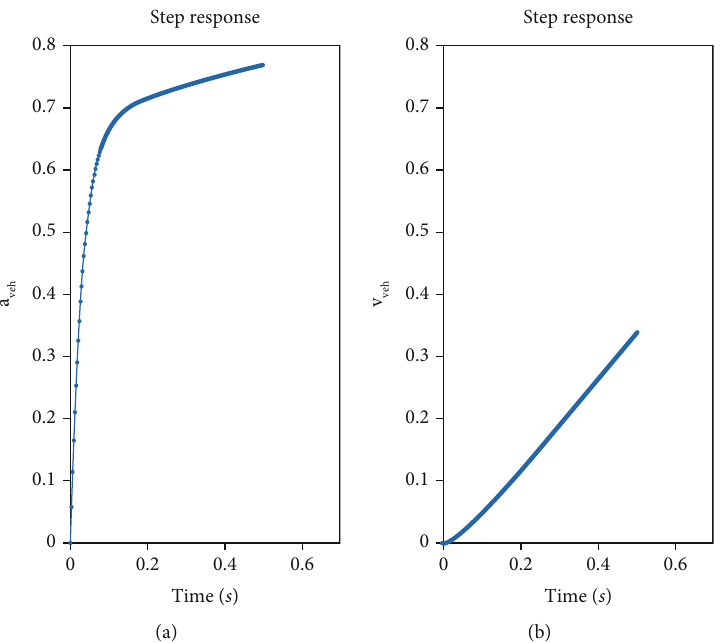
Figure 4: Vehicle acceleration (a) and velocity (b) responses, respectively, in PI (1).